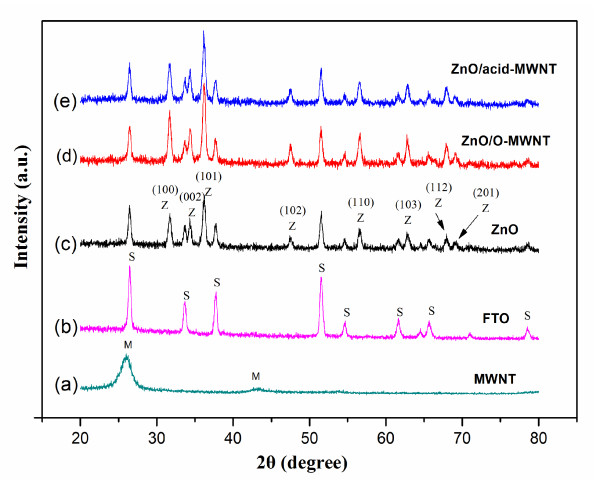
XRD spectra. (a) MWNT; (b) FTO glass substrate; (c) ZnO; (d) ZnO/O-MWNT film; (e) ZnO/acid-MWNT film. (M, MWNT; S, FTO substrate (SnO2); Z, ZnO).